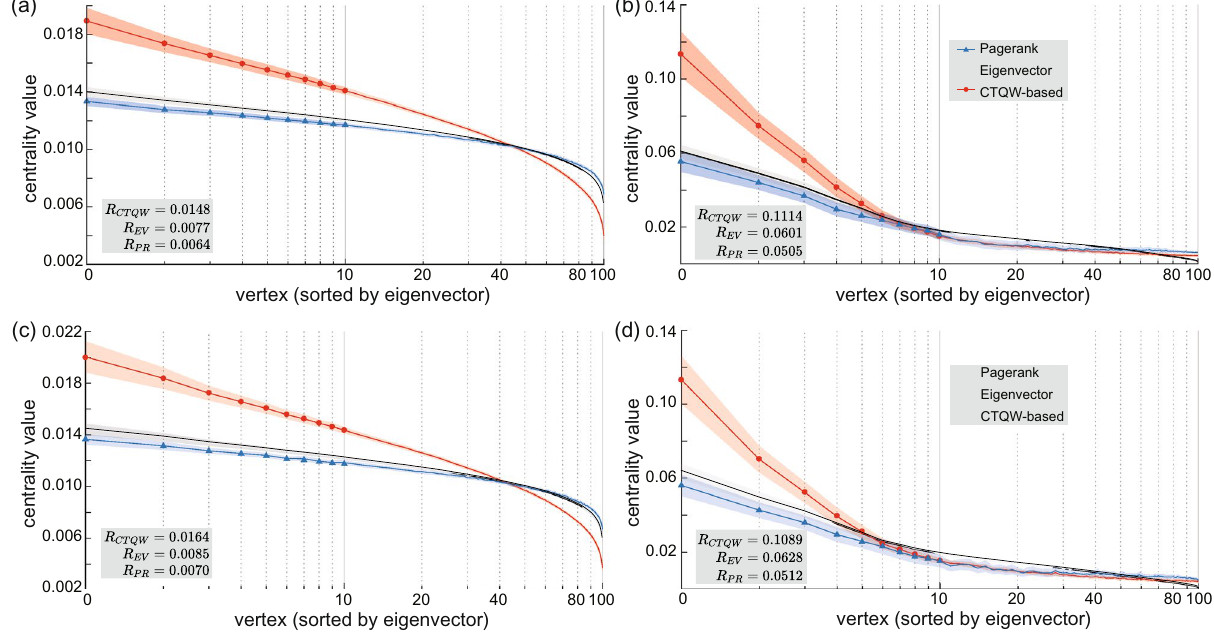
Figure 4. The average CTQW-based, eigenvector and PageRank centralities for vertices over an ensemble of 200 Erdős-Rényi graphs ER (100, 0.3) with only one weighted edge w = 2 ( a ), scale-free networks SF (100, 2) with only one weighted edge w = 2 ( b ), ER (100, 0.3) with all edges weighed in [1, 10] ( c ), and SF (100, 2) with all edges weighed in [1, 10] ( d ), The vertices are sorted by the eigenvector centrality measure and the shaded areas represent one standard deviation from the average centralities among 200 graphs. It is obvious that the range of CTQW-based centrality measure R CTQW is much bigger than other